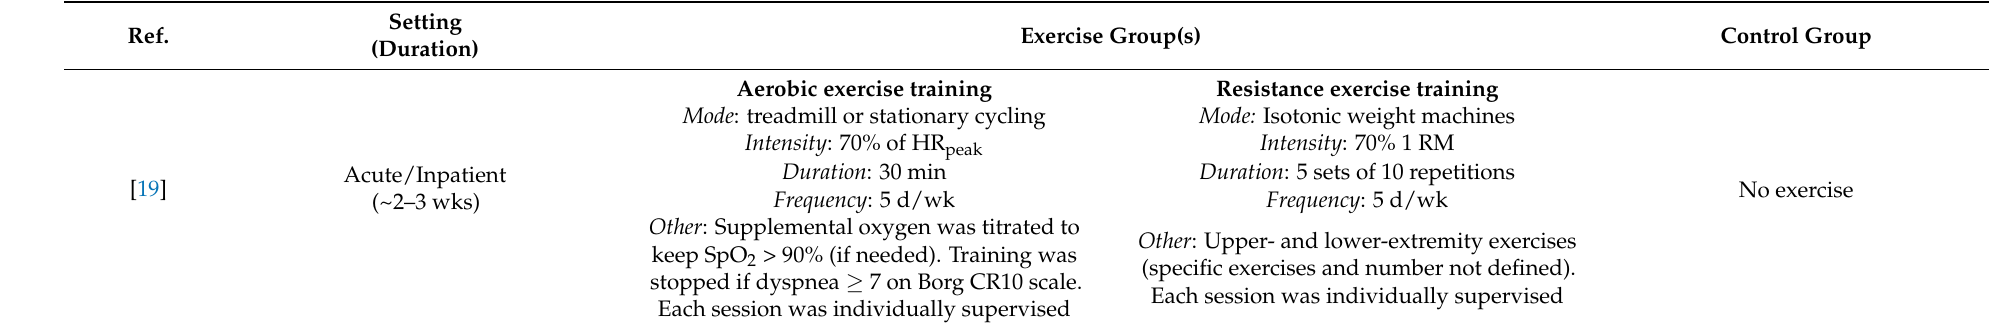
Table 3. Characteristics of intervention setting and groups.